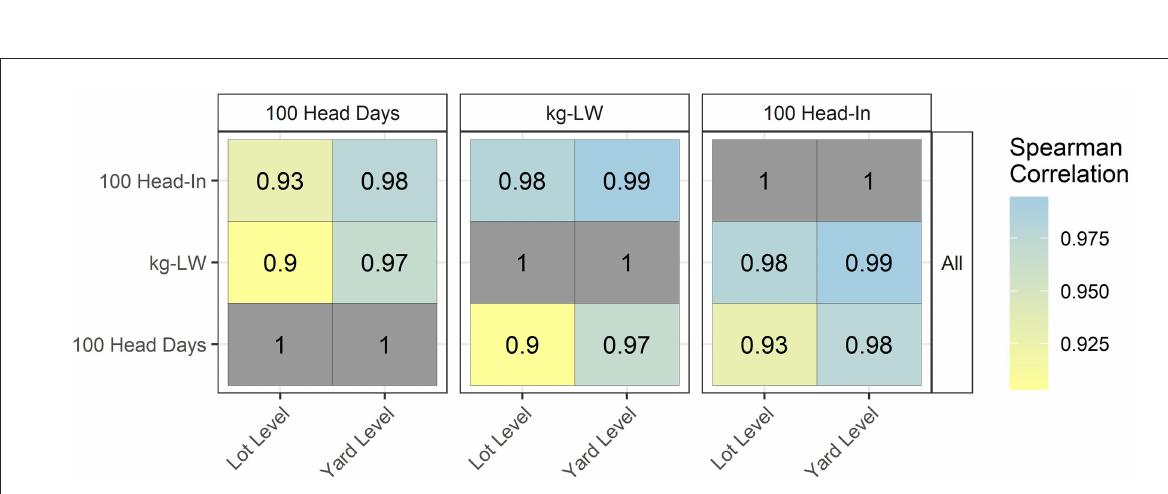
FIGURE6 Correlation of 3 denominators at the lot and feedyard (yard) levels for all use categories